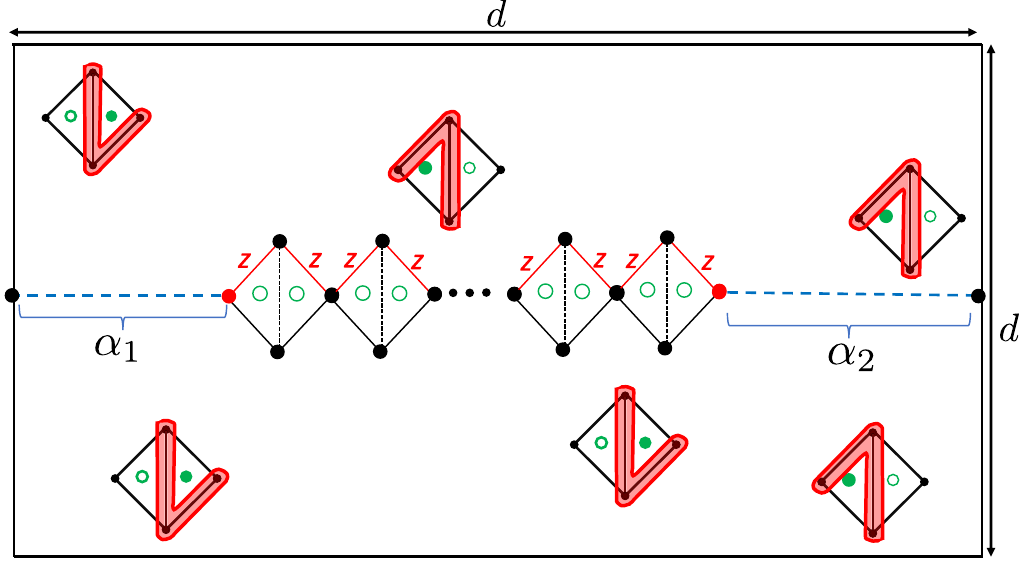
FIG. 14. Illustration of a case where there are m 1 flags, each resulting from a measurement error, and m 2 consecutive Z errors resulting (the particular error type is not important) in two highlighted vertices. We have the constraint that m 1 þ m 2 ≤ bð d − 1 Þ = 2 c . The graph can be any graph associated with a distance d heavy-square or heavy-hexagon code. Hence, α 1 þ α 2 ≥ bð d þ 1 Þ = 2 c . The dark lines represent the boundaries of the graph.